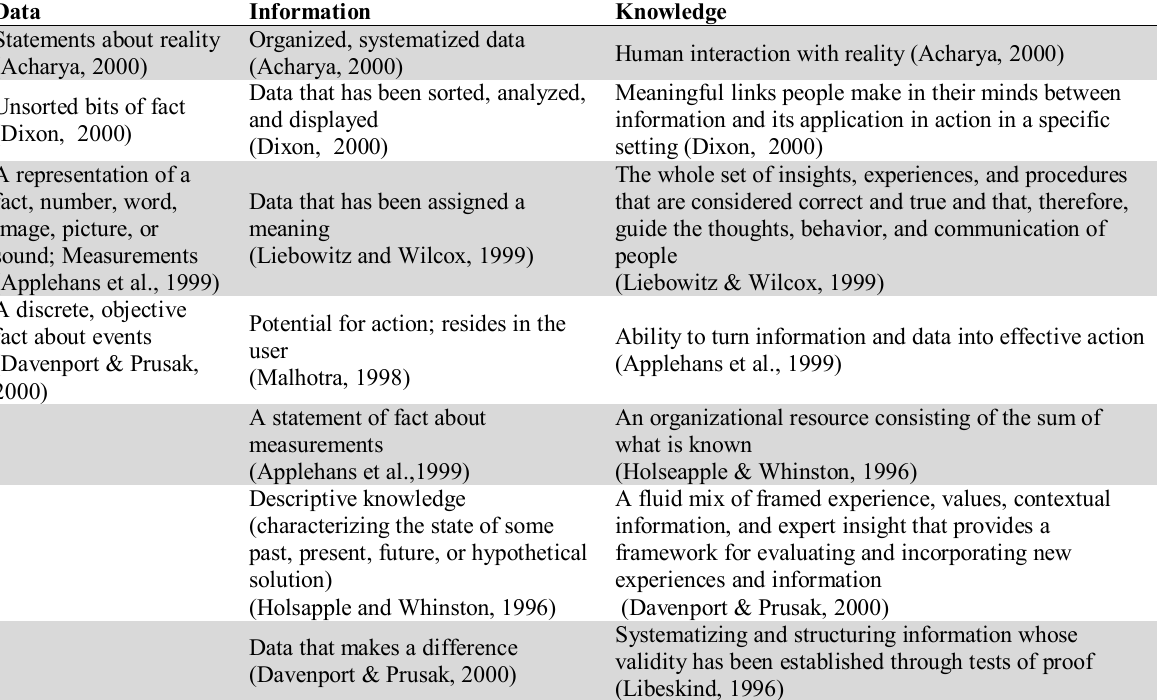
Definitions of data, information and knowledge (adapted from Awad and Ghaziri,